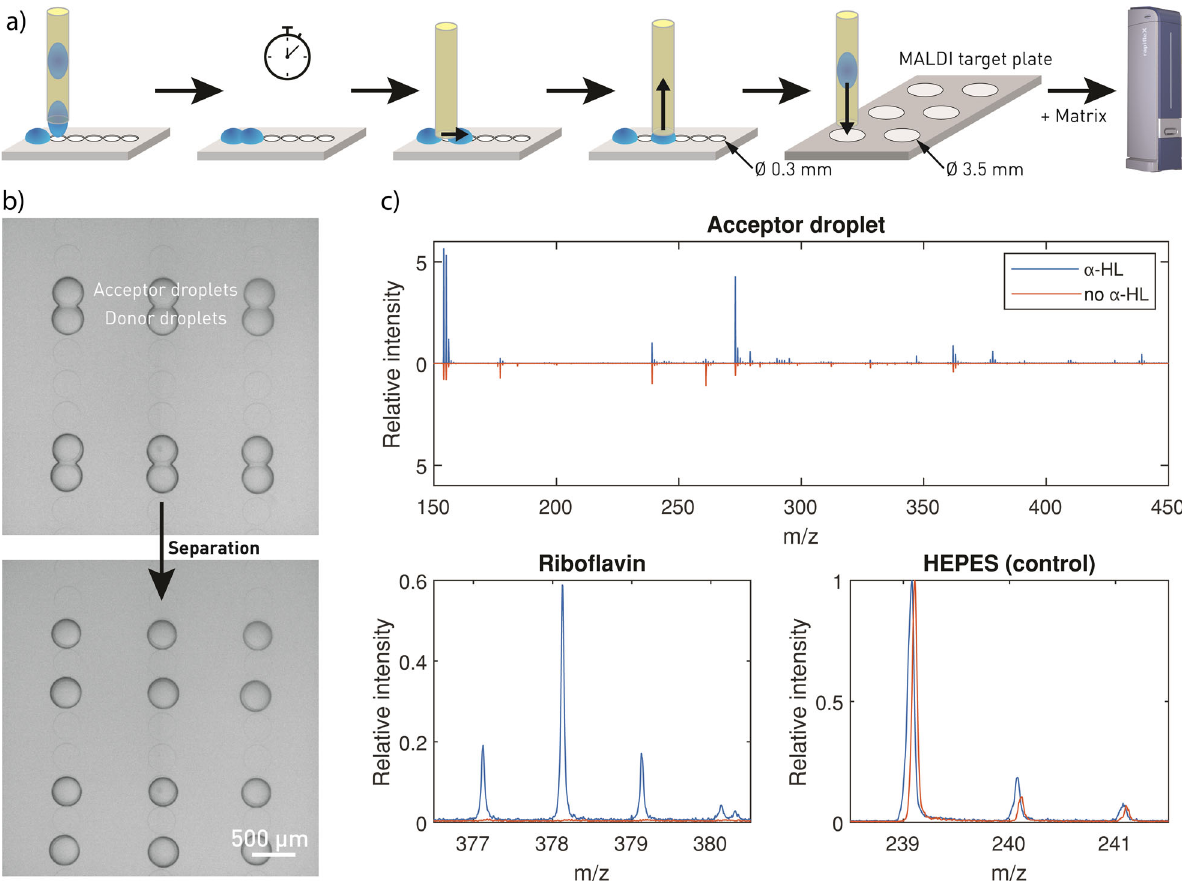
Fig. 4 Label-free detection of translocation across alpha-hemolysin ( α -HL) pores with mass spectrometry. a Scheme of droplet separation and extraction for MALDI-MS analysis (not to scale). From left to right: droplet spotting; incubation step for allowing translocation; droplet separation; droplet aspiration; placing the droplet on a stainless-steel MALDI target plate; and MALDI-MS analysis after matrix (DHB) deposition. b Droplets connected by a droplet interface bilayer (top) and droplet pairs after separation (bottom). c MALDI-MS analysis of accepter droplets, where the donor droplet contained ribo fl avin (377.1 m / z ) and the acceptor droplet contained α -HL (blue) or not (orange, here fl ipped for better visualization). Data are shown for n = 1 droplet network. The isotopic pattern for ribo fl avin 53 and HEPES, again with (blue) and without (orange) addition of α -HL. Each spectrum is normalized to the intensity of the internal control HEPES (239.1 m / z